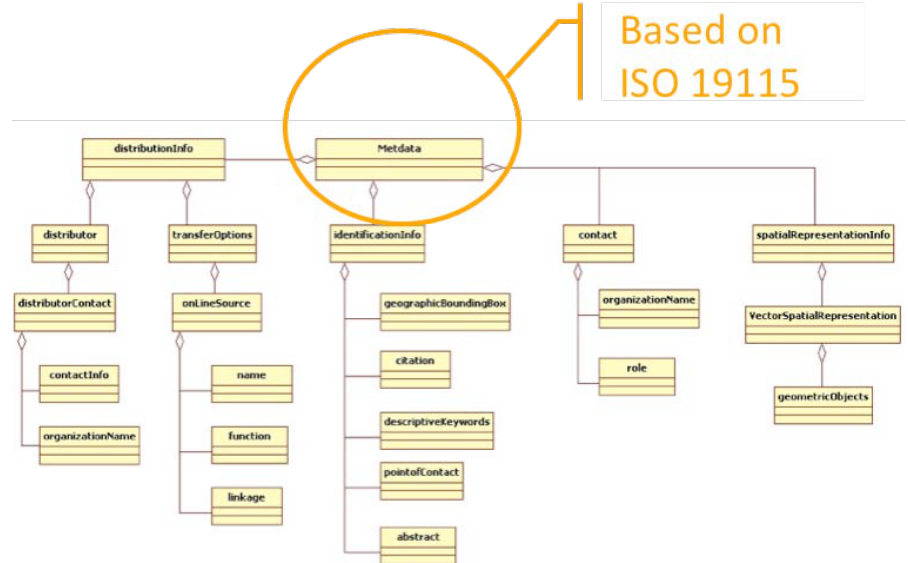
Fig. 4. Simplified GI-cat data model.